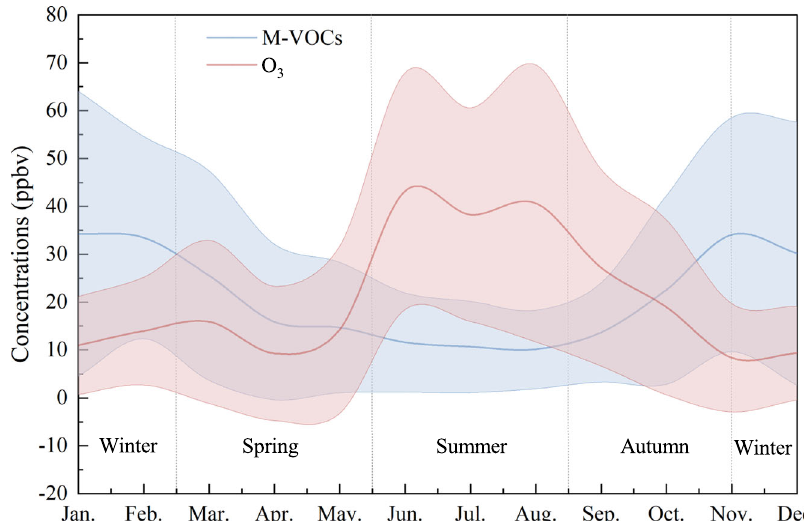
Fig. 1 The concentrations of measured VOCs (M-VOCs) and O 3 from January to December in 2018. Bold solid lines and shaded sections show the observed mean and standard deviation, respectively. From summer to winter, the variations of VOCs and O 3 show clear opposite trends. Annual mean concentration of M-VOCs was about 21.4 ± 26.8 ppbv, varying between 10.8 ± 9.3 ppbv in summer and 32.6 ± 26.1 ppbv in winter. The annual mean concentration of O 3 was about 20.4 ± 0.1 ppbv, ranging from 11.4 ± 10.4 ppbv (winter) to 40.7 ± 25.3 ppbv (summer). The hourly concentrations of measured VOCs, four VOCs categories and O 3 are shown in Supplementary Fig.